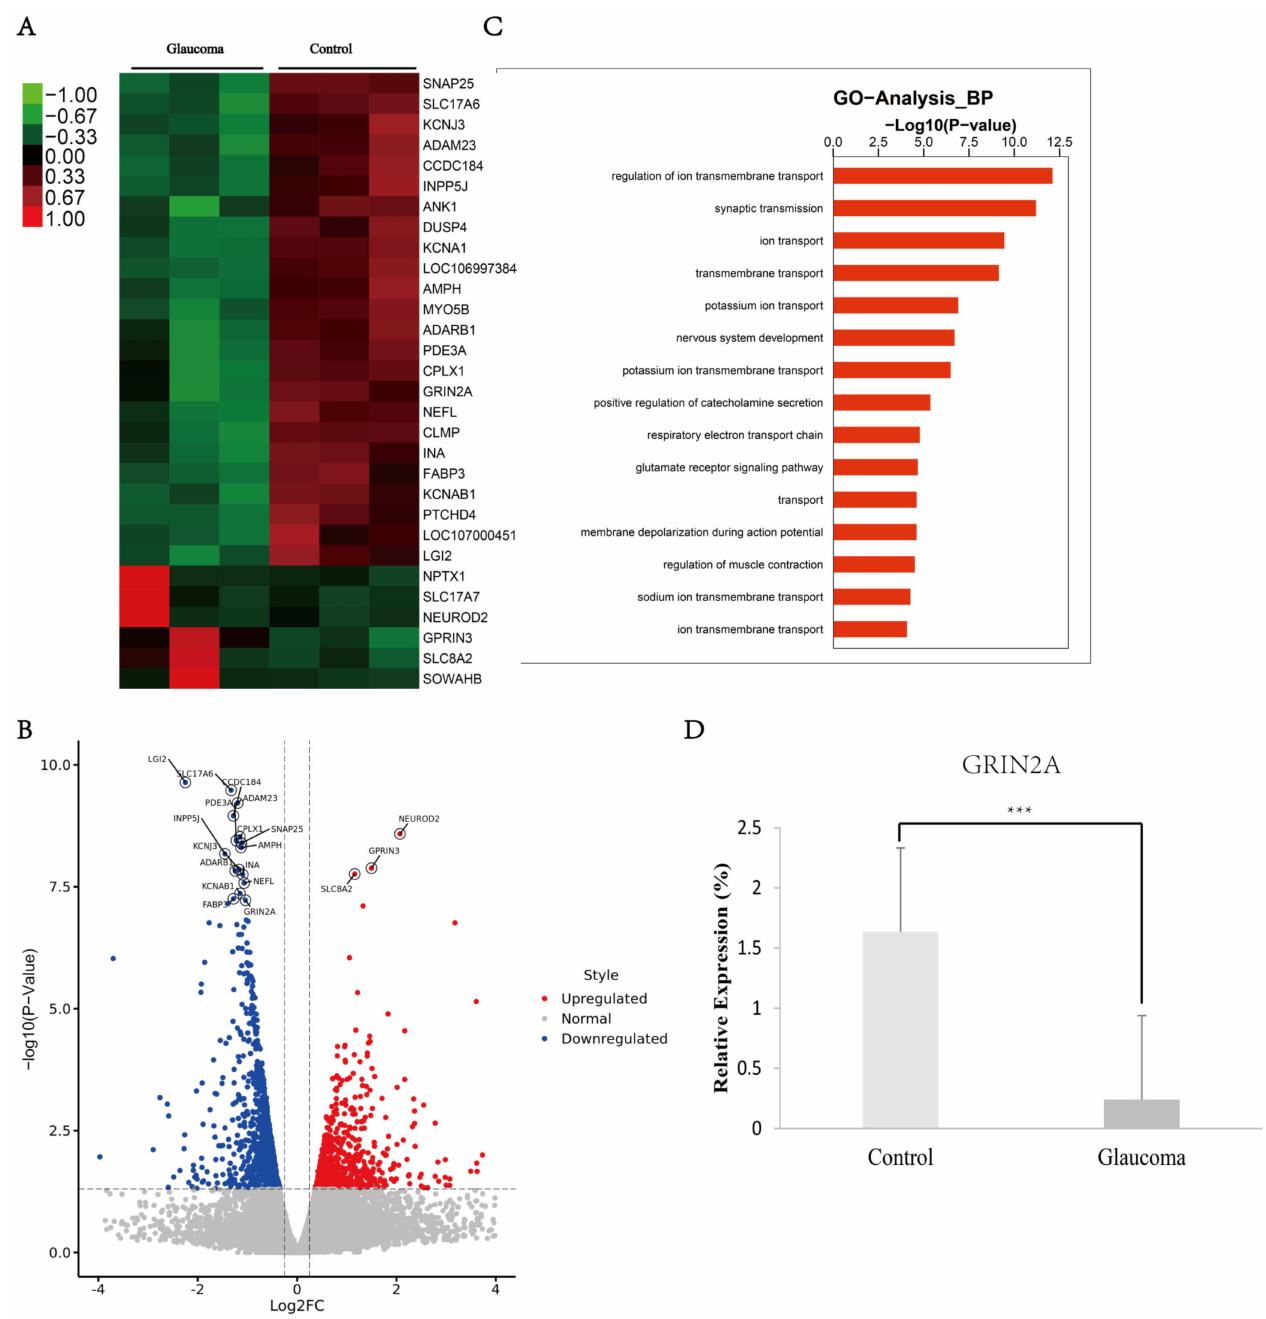
Figure 1. Differentially expressed genes in LGN of macaque glaucoma model. ( A ) Differentially expressed genes are calculated, heat-map showed the top differential genes; ( B ) volcano map of selected differentially expressed genes; ( C ) GO pathway analysis for differentially expressed genes; ( D ) QPCR detection of GRIN2A in LGN of macaque glaucoma model. ***, p <